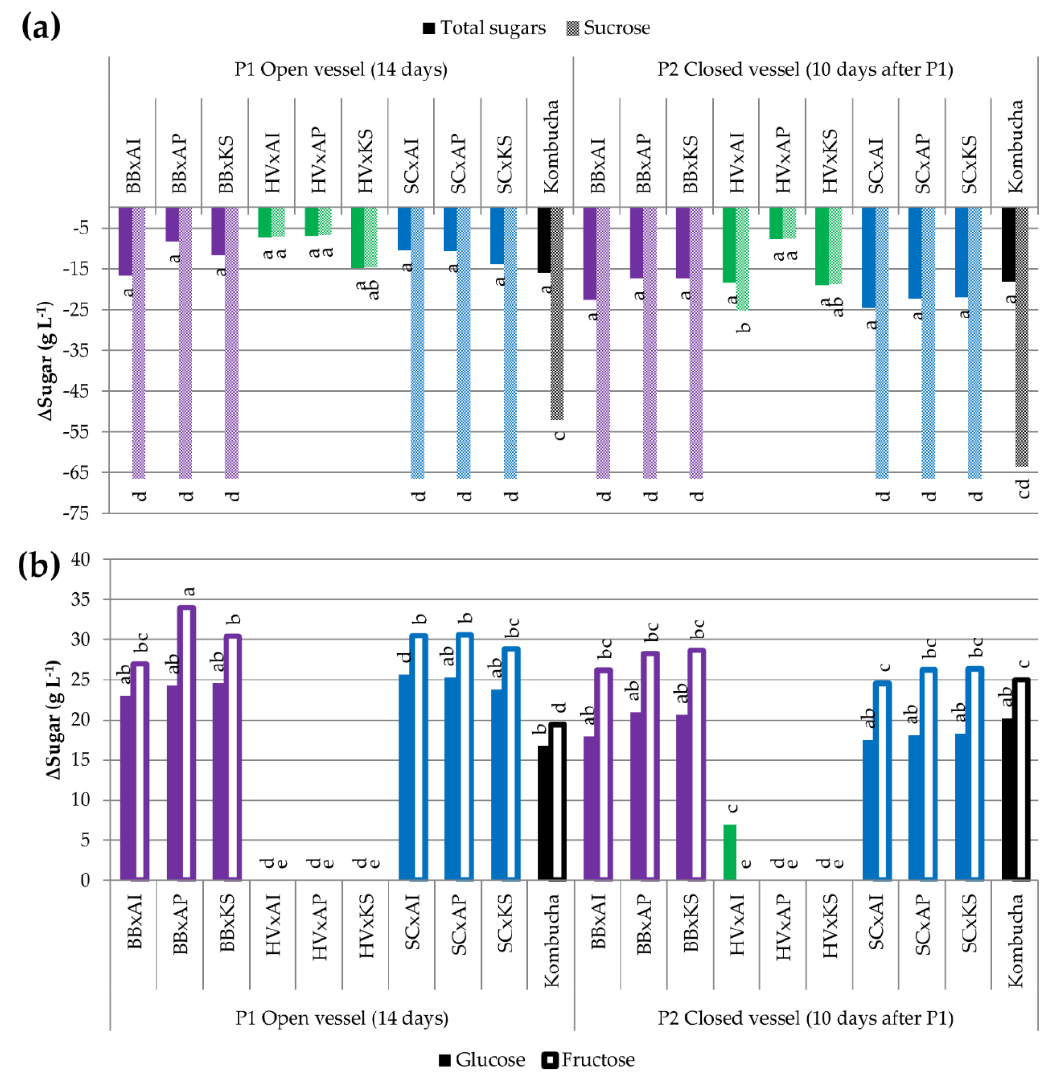
Figure 4. Di ff erence in total sugars and sucrose ( a ) and in glucose and fructose ( b ) (g L − 1 ) of samples between day 0 (after inoculation) and the end point (14 days for pure cultures, 14 days in an open vessel for P1, and 10 days in a closed vessel following P1 for P2). ANOVA was performed with α = 0.05 and n = 3. Common letters imply non-significant di ff erences between means. Colors reflect the yeast species in the coculture. BB = Brettanomyces bruxellensis (purple), HV = Hanseniaspora valbyensis (green), SC = Saccharomyces cerevisiae (blue), AI = Acetobacter indonesiensis , AP = Acetobacter papayae , KS = Komagataeibacter saccharivorans , and “x” = a coculture.